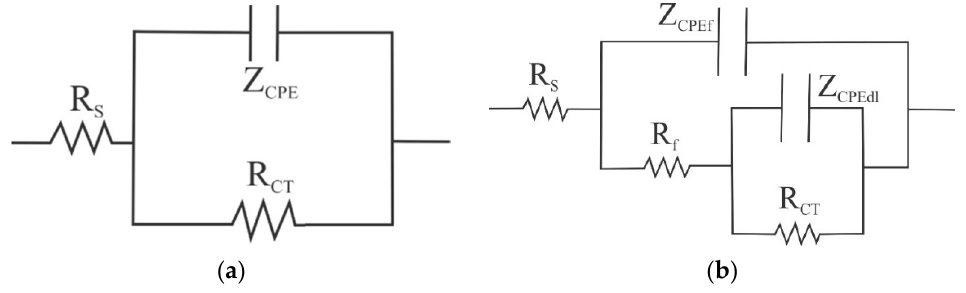
Figure 8. Equivalent circuits: ( a ) without inhibitor; ( b ) with inhibitor.